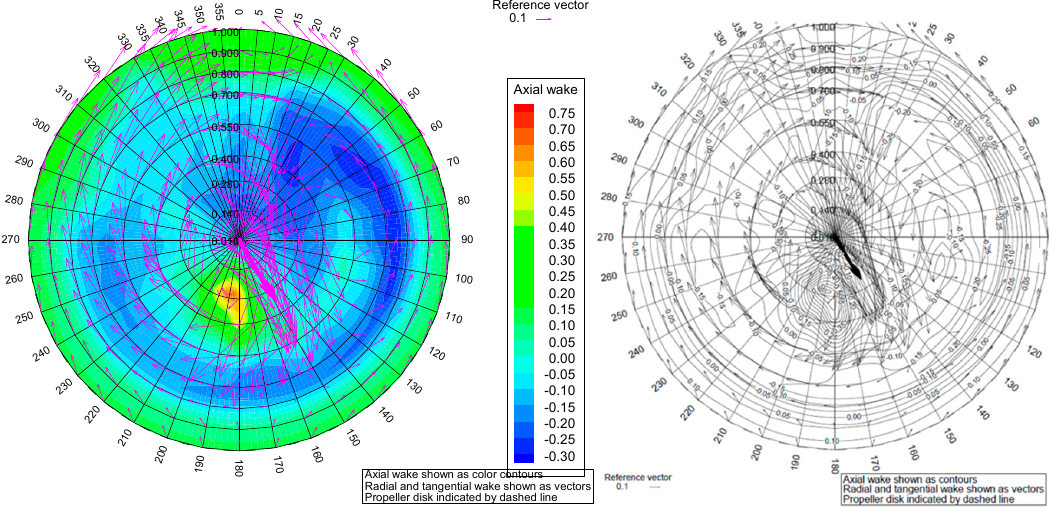
Figure 24. 3D wake measurements at a rudder stock plane (AP), with a working propeller, with PSS, at 14 kn.